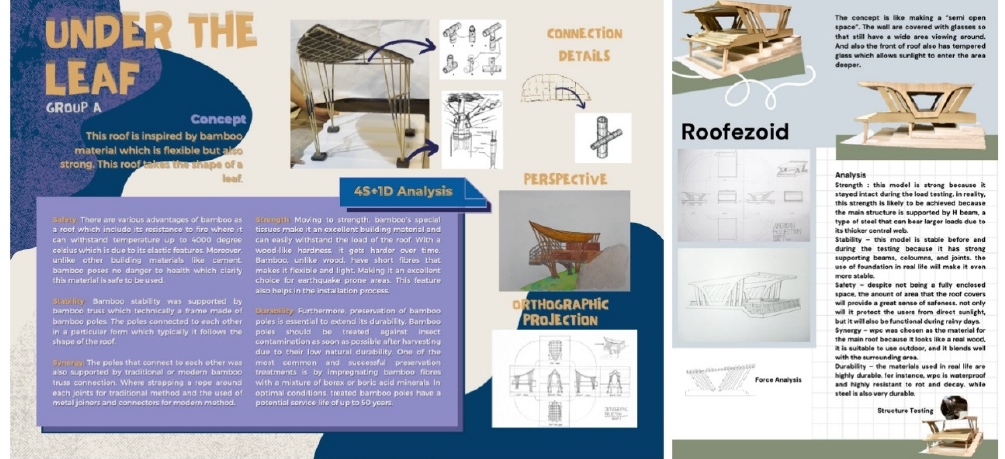
Figure A1. Under the leaf.